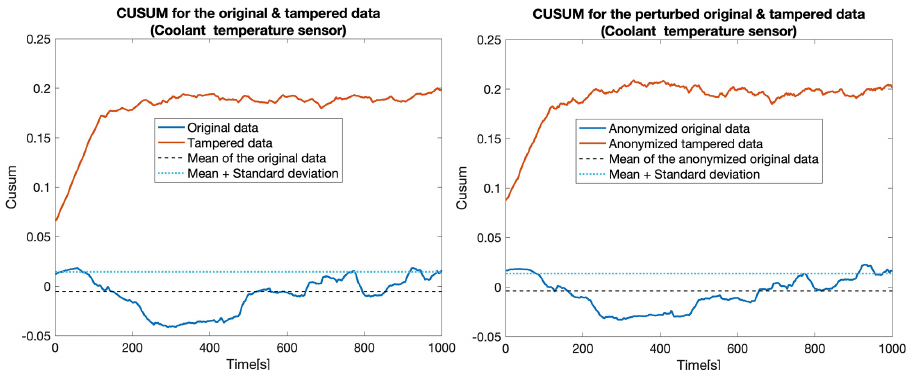
Figure 7. CUSUM for the original data (blue) and tampered data (orange) for the Coolant tempera- ture sensor.